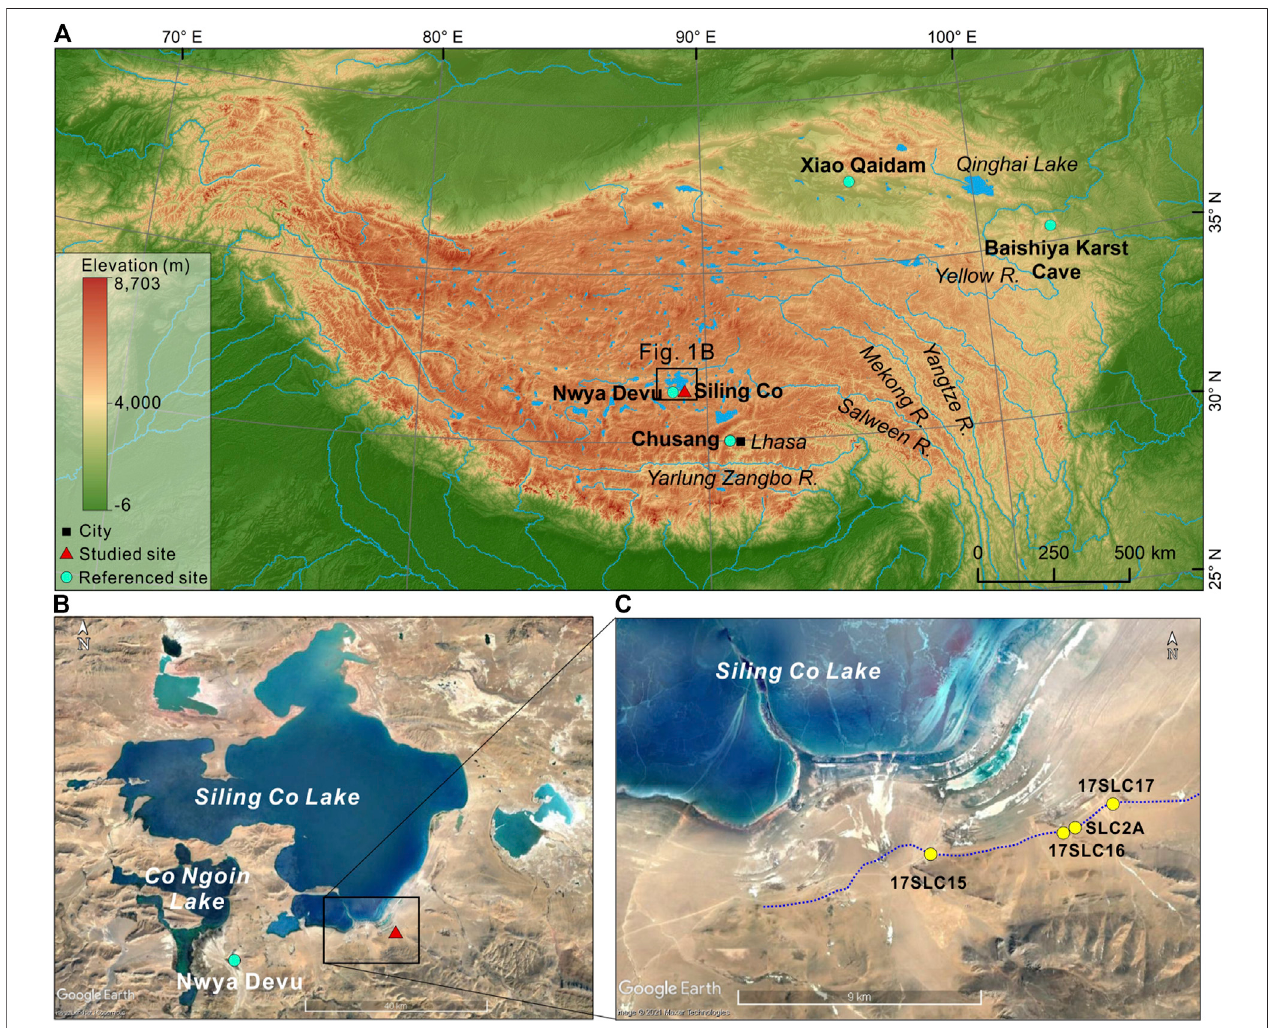
FIGURE 1 | The locations of the studied Siling Co Paleolithic site and sections. (A) Map showing the locations of the Siling Co site and four other Paleolithic sites (lightbluedots)ontheTibetanPlateauwithpossibleagesoftheLGMorolder. (B) LocationoftheSilingCositeinrelationtoSilingCoLake,CoNgoinLake,andtheNwya Devusite. (C) Locationsofthefourinvestigatedsections(yellowdots)alongthepaleo-shorelineatanelevationof ∼ 4,600 m(bluedashedline).Artifactswerefoundonthe ground surface of sections 17SLC16 and SLC2A. Digital elevation model data for (A) from http://vterrain.org/Elevation/global.html. Satellite imagery for (B , C) courtesy of Google